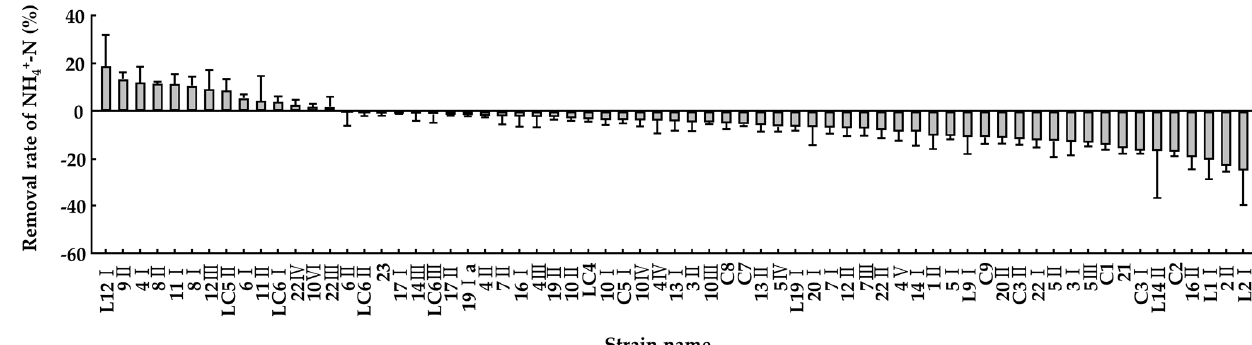
Figure 3. Ammonia removal rate of candidate bacterial strains in liquid medium with NH 4 Cl by using indophenol method. Values represent the mean ± S.E. ( n = 3).